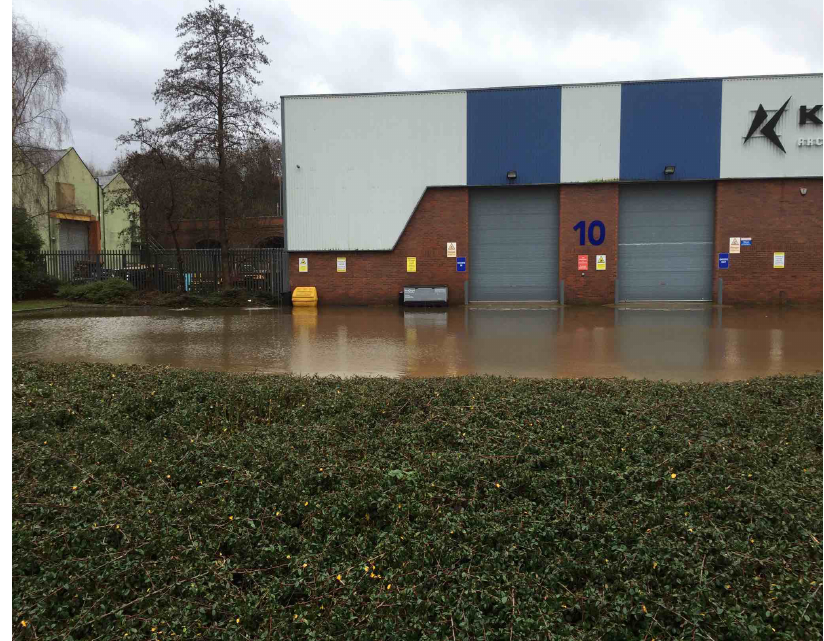
Figure 5. Flooding starts at Kirkstall on 26 December 2015 at 12:18 with the Armley river level recorded at 4.16 m, which motivates one to take a threshold river level at h T = 3.9 m. Photo courtesy Jessica Worsey.